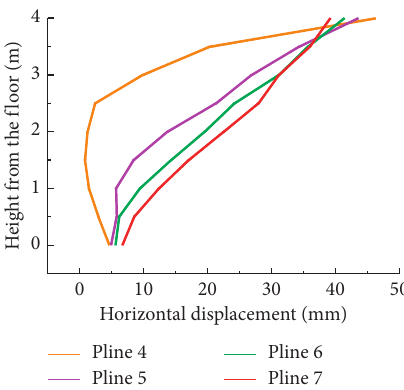
Figure 11: Horizontal displacement of coal side versus height from the floor curves of the results from pline 4, 5, 6, and